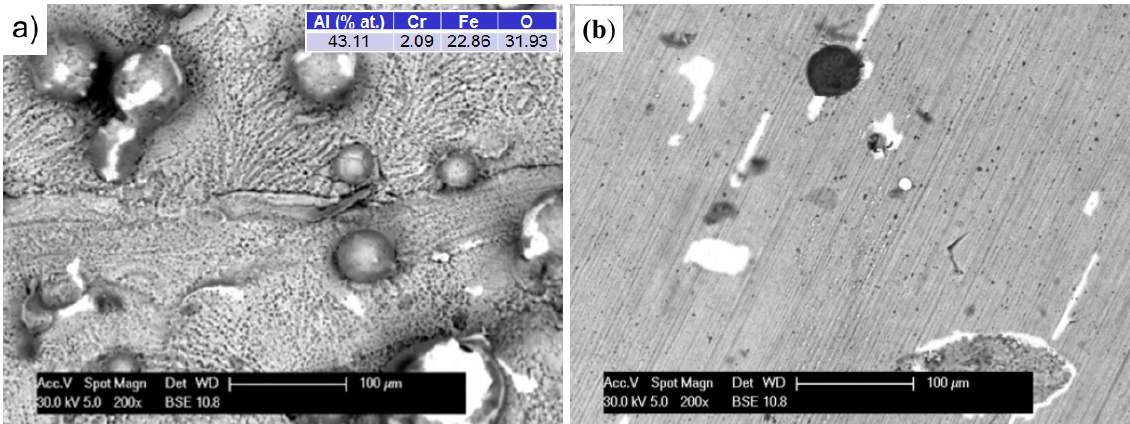
Figure 7. The morphology (BSE) of the surface specimens after oxidation at 1000 °C/50 h in state after: processing of A-sample ( a ) and processing and grinding of B-sample ( b ). Colors: gray—the oxide layer; white—the exposed surface of the substrate, which is re-oxidation; and dark (black)—impurities from the manufacturing or grinding process.